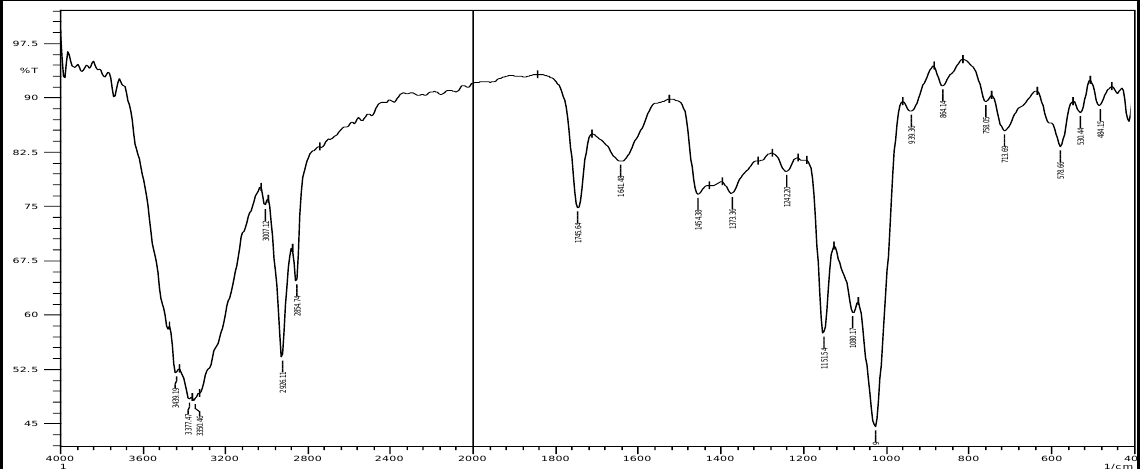
40060080010001200140016001800200024002800320036004000 Figure 4. The IR spectrum of the isolated compound